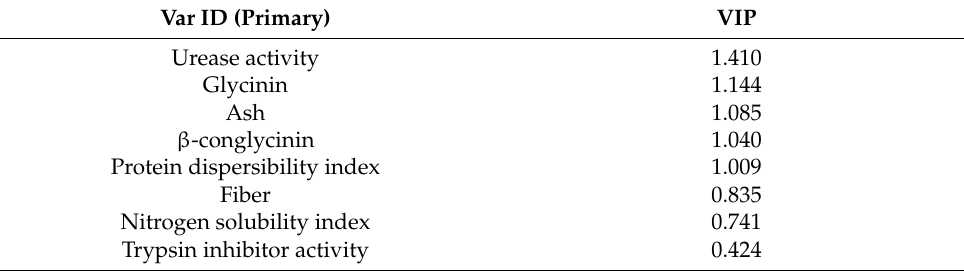
Figure 4. ( A ) The scaled PLS regression coefficients between X , ash, fiber, protein dispersibility index (PDI), nitrogen solubility index (NSI), urease activity (UA), trypsin inhibitor activity (TIA), glycinin, β -conglycinin, and Y , survival rate (SR); ( B ) the scaled PLS regression coefficients between X and Y , weight gain rate (WGR). The scaled regression coefficients were weighted. The bars indicate 95% confidence intervals based on jack-knifing. Table 9. Variable importance in the projection (VIP) general